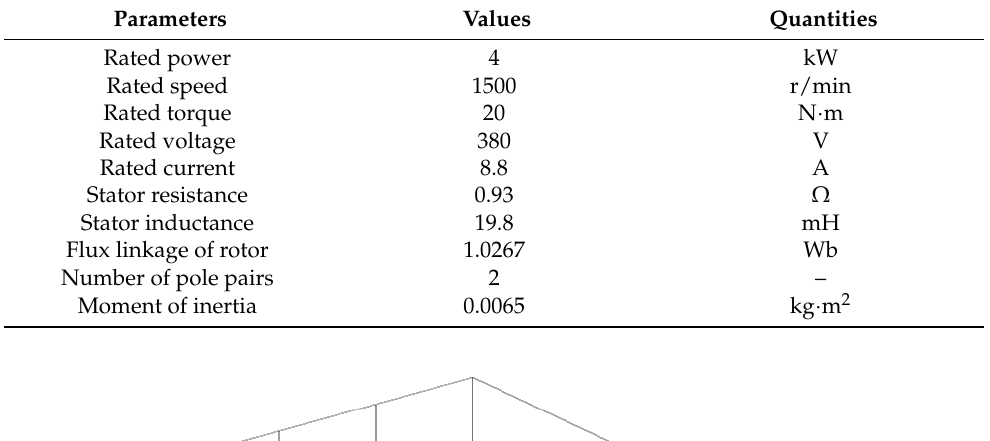
Table 2. Parameters of SPMSM.